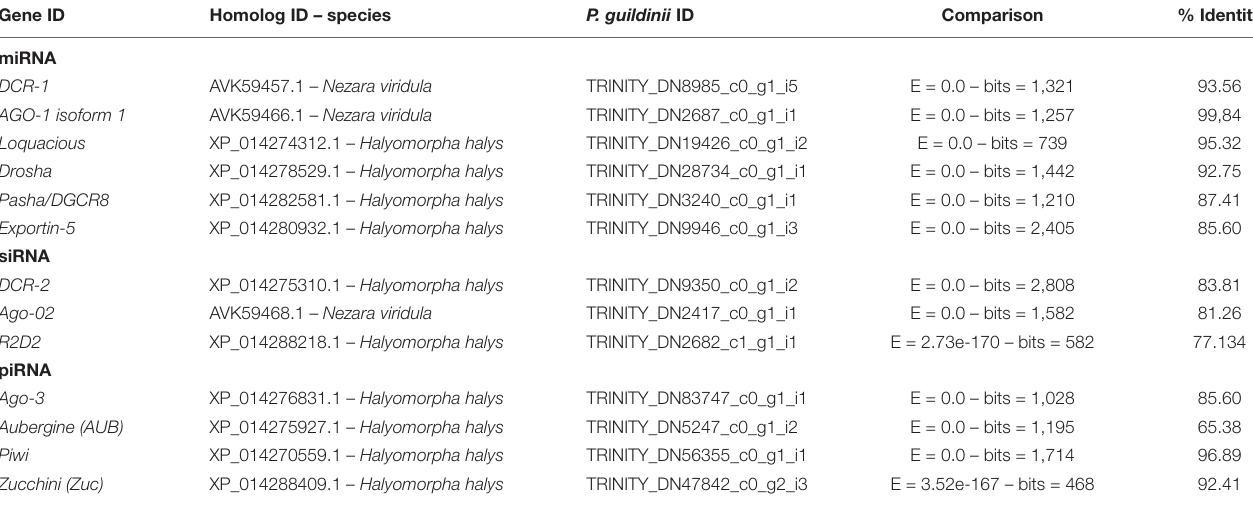
TABLE 1 | Core RNAi related genes identified in Piezodorus guildinii transcriptome.